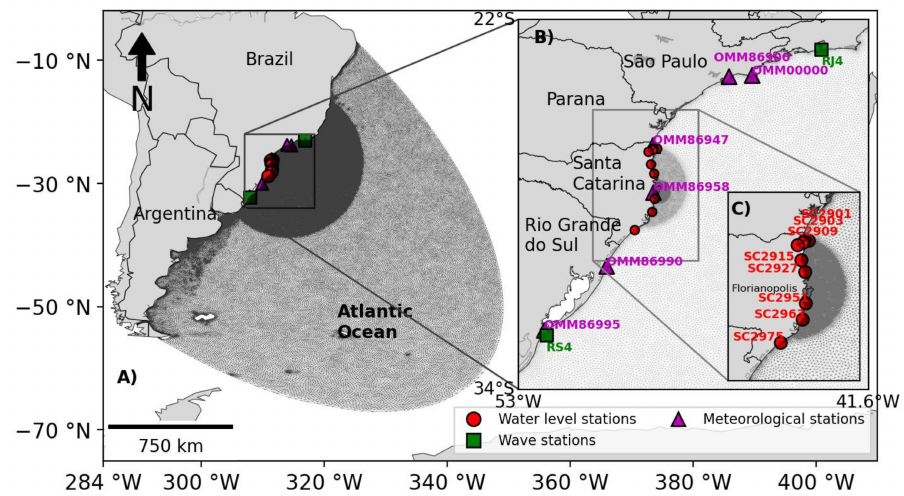
Figure 1. Location map of the study area. ( A ) Numerical modeling domain; ( B ) Southern Brazilian continental shelf region; ( C ) Santa Catarina state coastal